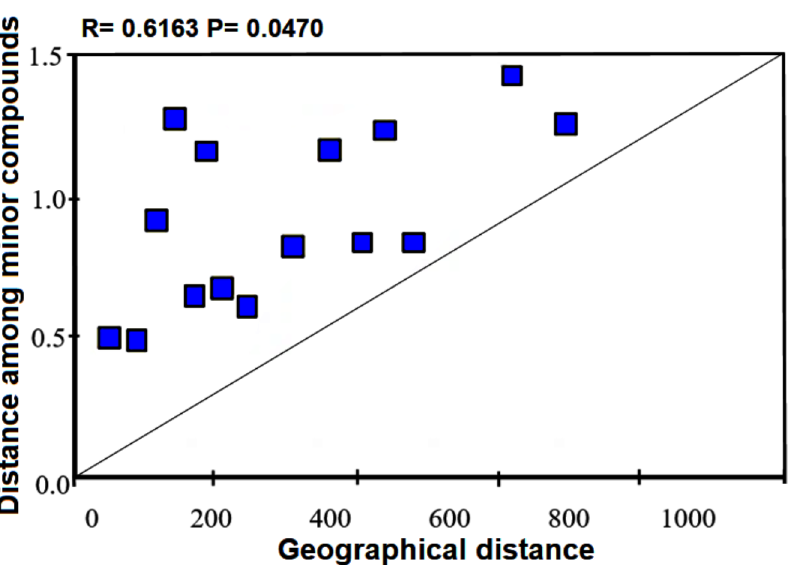
Figure 9. Correlation analysis using Mantel test between minor compounds and geographical distances ( p <